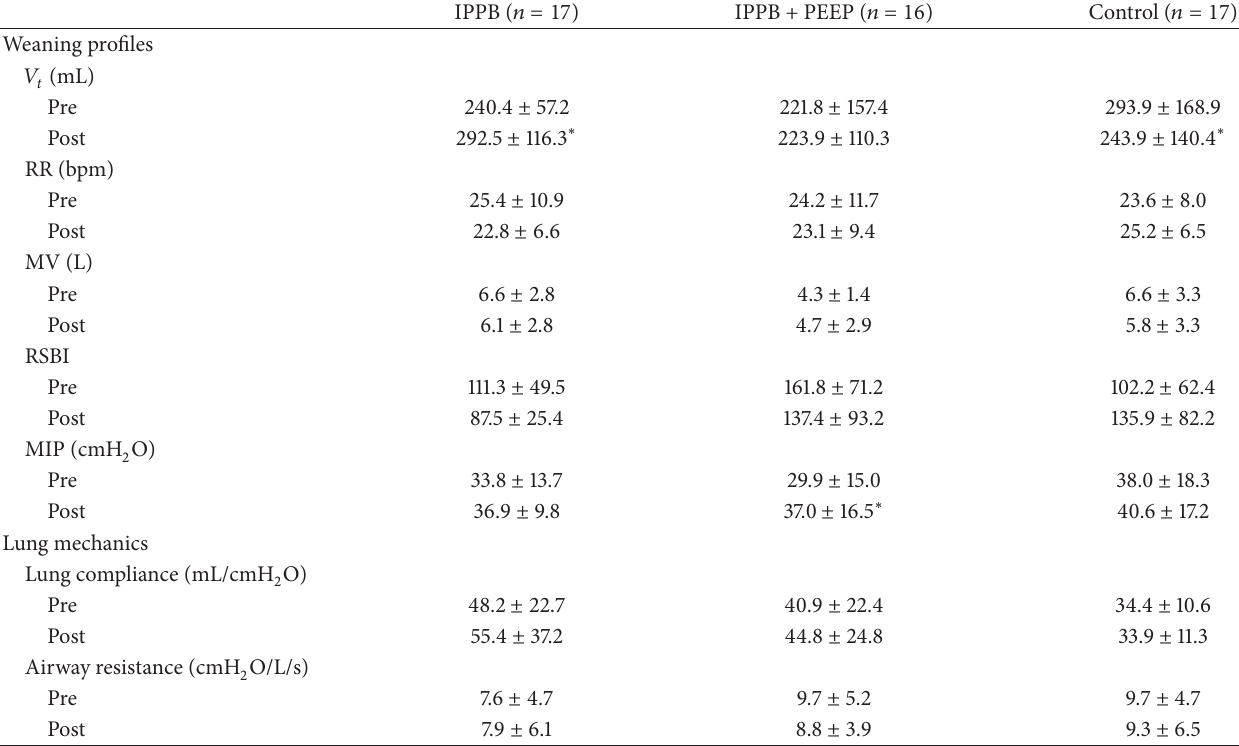
Table 2: Comparison of weaning parameters and lung mechanics values between